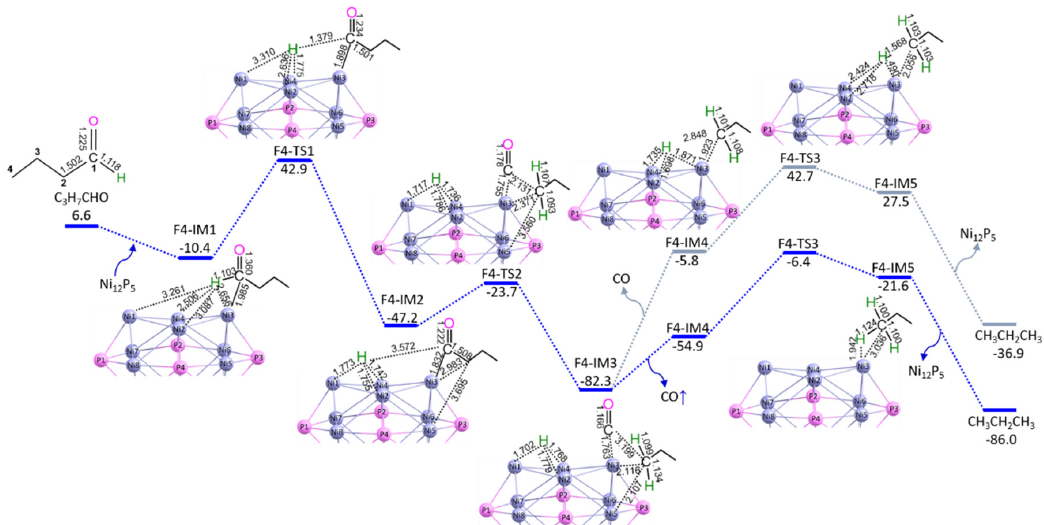
Figure 4. The potential energy curves with the relative Gibbs free energy ( G r , kJ mol − 1 ) and the geo- metric structures with bond lengths (Å) for reaction stage S4 over Ni 12 P 5 cluster at GGA − PBE/DSPP, DNP level. For brevity, some hydrogen atoms are hidden. CO ↑ shows the CO pressure with 10 − 5 atm under experimental